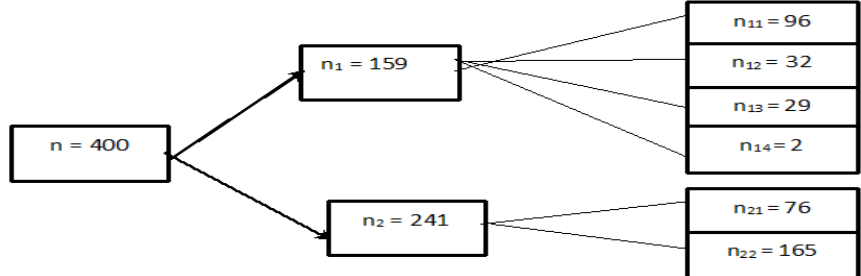
Figure 1. Sample size for each stratum.